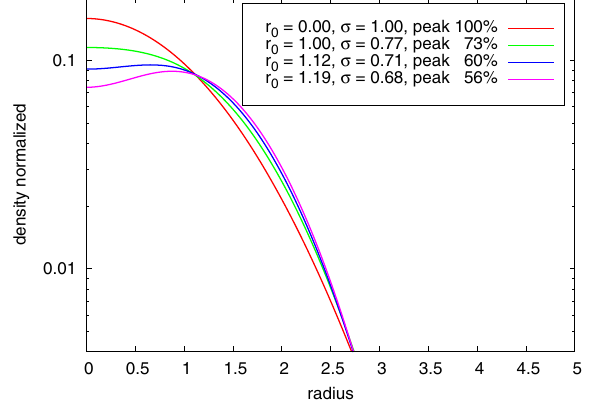
FIG. 4. Computed profiles for different rotation radii and beam rms widths in comparison to a nonrotated beam (red line).